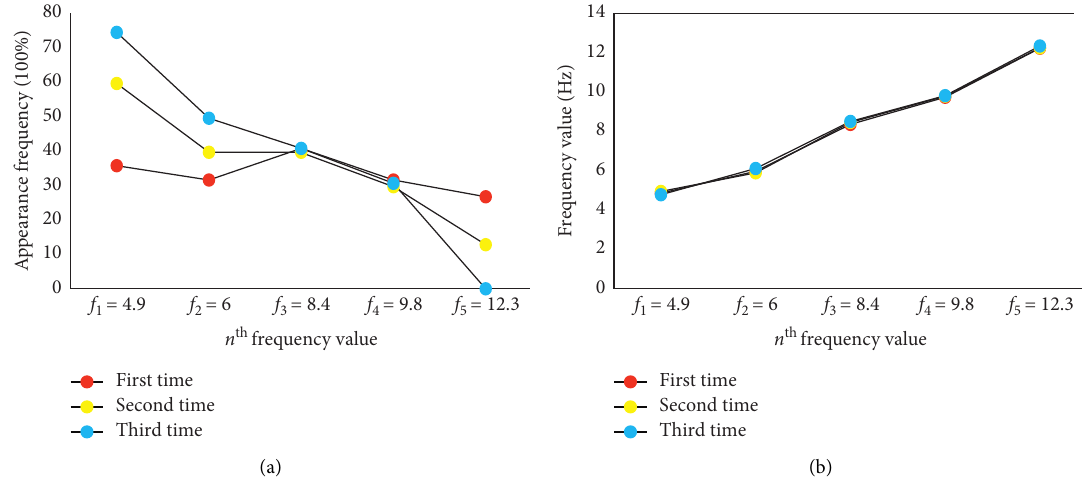
Figure 23: Changes in AF values and natural frequencies of the 1st span of Thu Duc 2 flyover bridge in 3 different measurement periods.